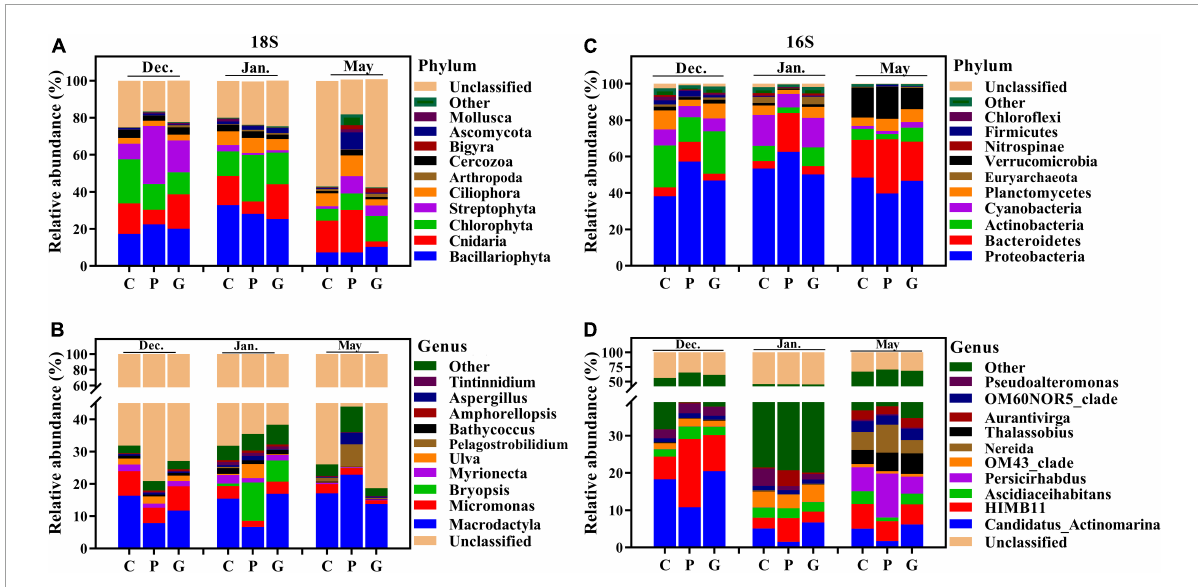
FIGURE3 Microbial community composition across different cultivation periods at the three study sites. Relative abundance of different phyla (A) and genera (B) based on 18S and different phyla (C) and genera (D) based on 16S in the 39 samples. The abundances are presented in terms of percentages of total effective sequences in a sample at the different